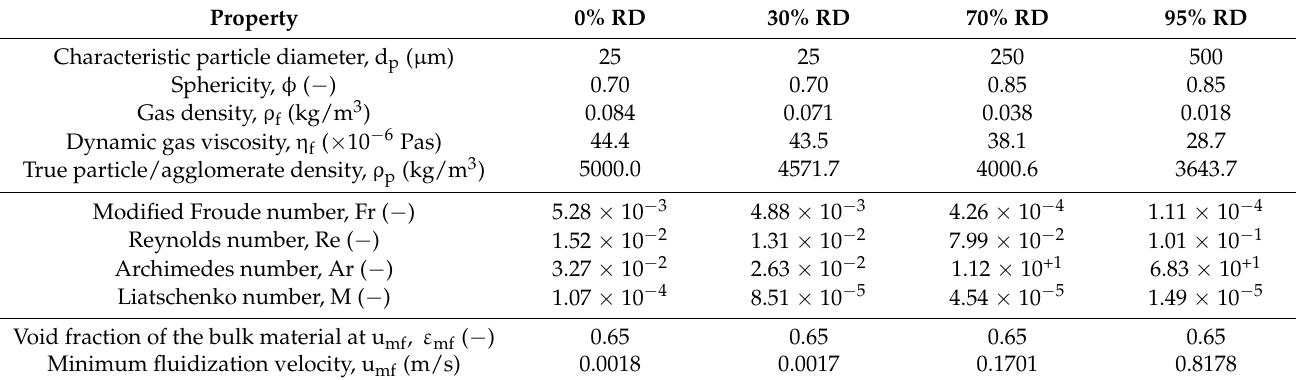
Table A4. Changing gas and bed material properties, dimensionless numbers, and minimum flu- idization velocity for reduction at 1173 K and the formation of agglomerates.